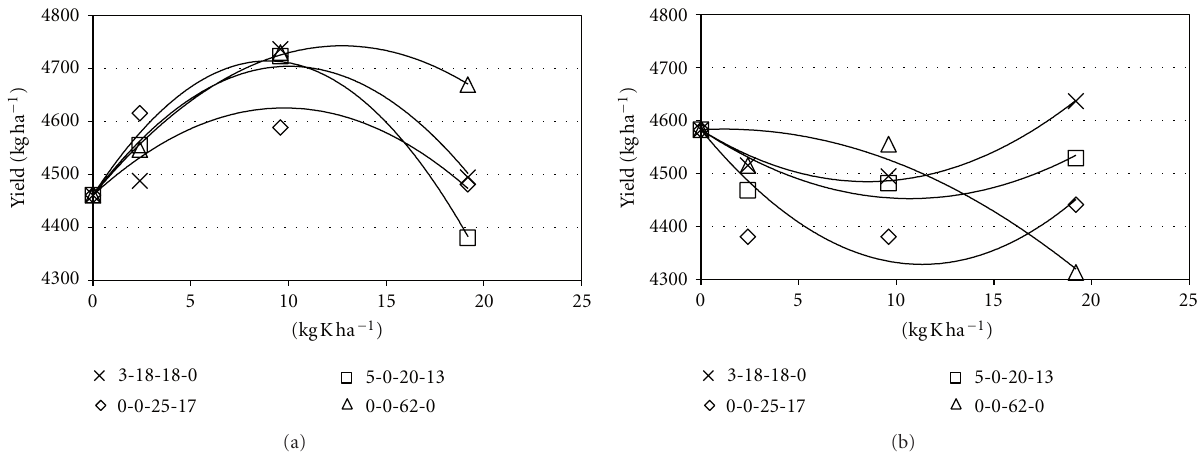
Figure 1: Soybean grain yield response to K-fertilizer additives (%N-%P 2 O 5 -%K 2 O-%S) of 3-18-18-0 ( y = 6 . 1901 x 2 + 48 . 436 x + 4461, R 2 = 0 . 86), 0-0-25-17 ( y = − 11 . 258 x 2 + 33 . 608 x + 4461, R 2 = 0 . 53), 5-0-20-13 ( y = − 0 . 4796 x 2 + 56 . 587 x + 4461, R 2 = 0 . 98), or 0-0-62-0 ( y = − 24 . 869 x 2 + 44 . 214 x + 4461, R 2 = 0 . 99) applied alone to weed-free plots (a) and with glyphosate to weedy plots (b) for 3-18-18-0 ( y = 3 . 622 x 2 − 22 . 952 x +4582, R 2 = 0 . 96), 0-0-25-17 ( y = 14 . 005 x 2 − 44 . 846 x +4582, R 2 = 0 . 51), 5-0-20-13 ( y = 8 . 2735 x 2 − 24 . 254 x +4582, R 2 = 0 . 41), and 0-0-62-0 ( y = 6 . 8447 x 2 + 1 . 9417 x + 4582, R 2 = 0 . 88) at Novelty in 2004. The nontreated, weed-free, and glyphosate plus nonionic surfactant plus diammonium sulfate grain yields were 650, 4460, and 4700 kg ha − 1 , respectively. Comparisons between figures are valid. The LSD ( P = 0 . 01) was 330 kg ha − 1 .